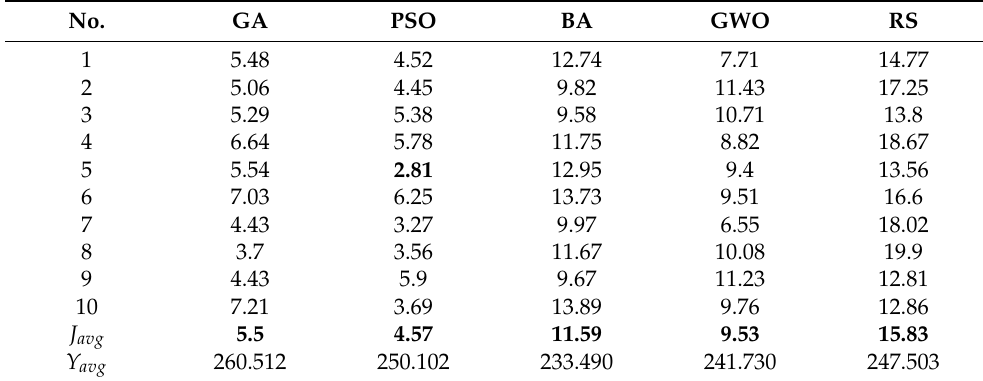
Table 1. The results of experiments: direct